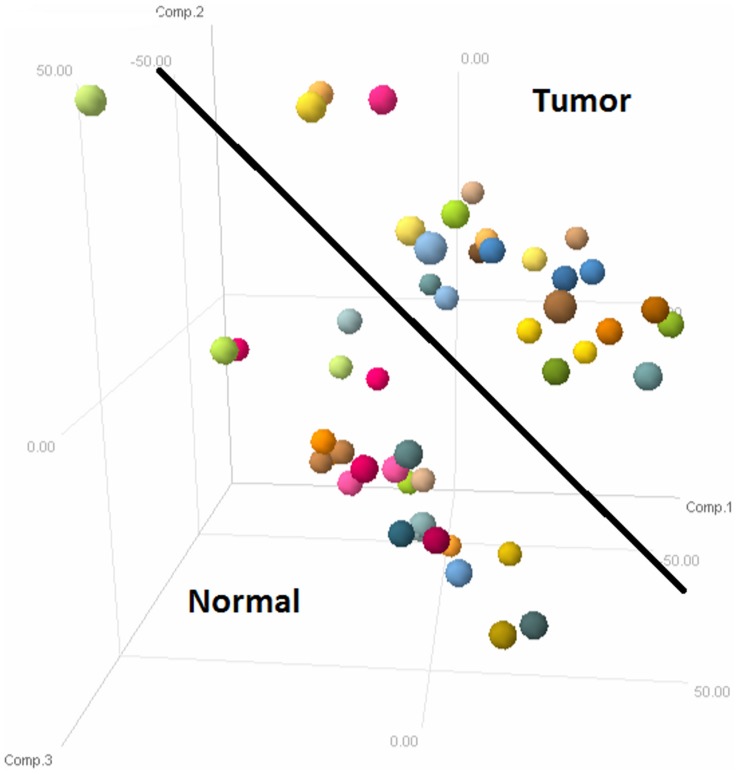
Principal Component Analysis of Exon array data from 32 patients.60 samples from 32 patients were subjected to PCA and the outliers were removed. 4 normal and 7 tumour samples were removed from the final analysis.